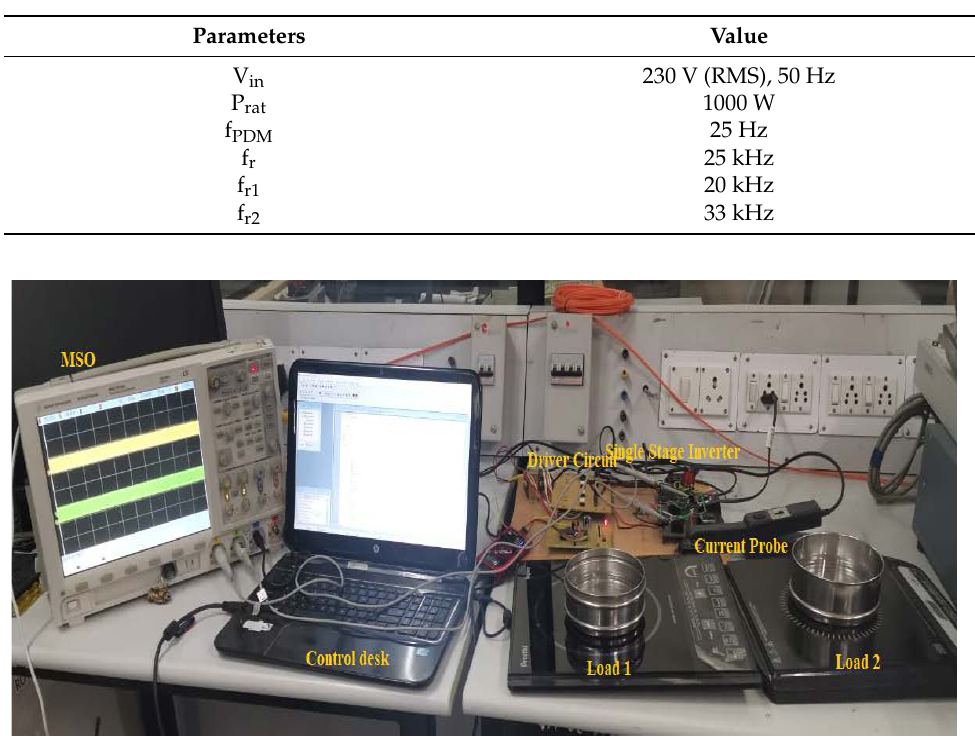
Figure 6. The test set up of the IH system.